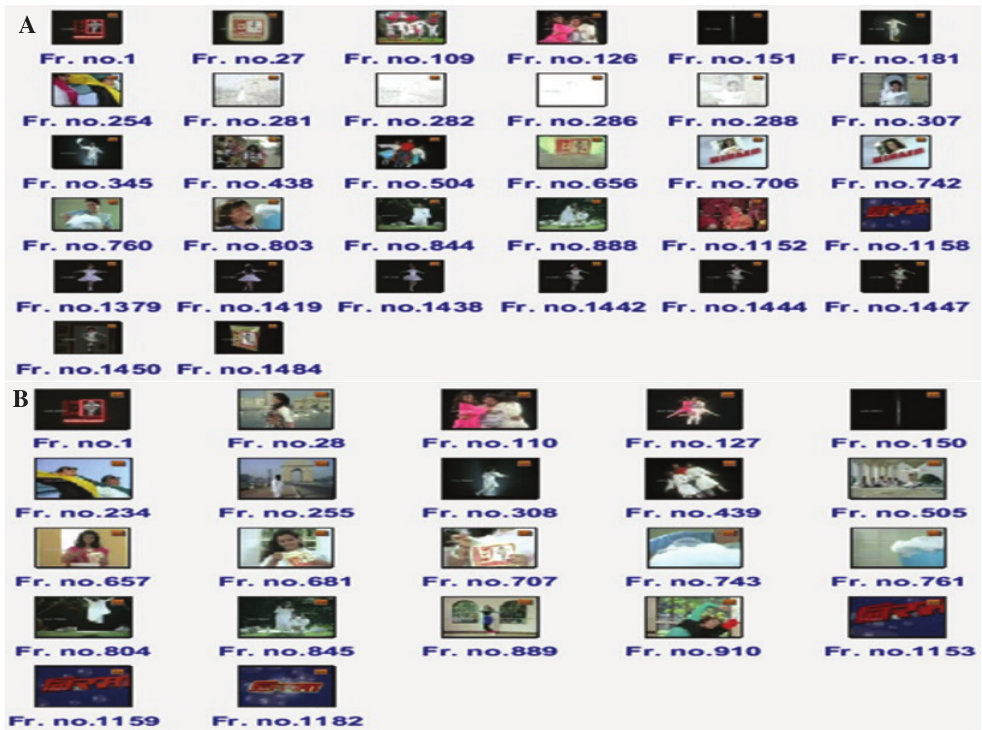
Figure 2: (A) Scene Change Detected Frame Using Histogram-Based SESAME and HiBisLI (B) FFMPEG